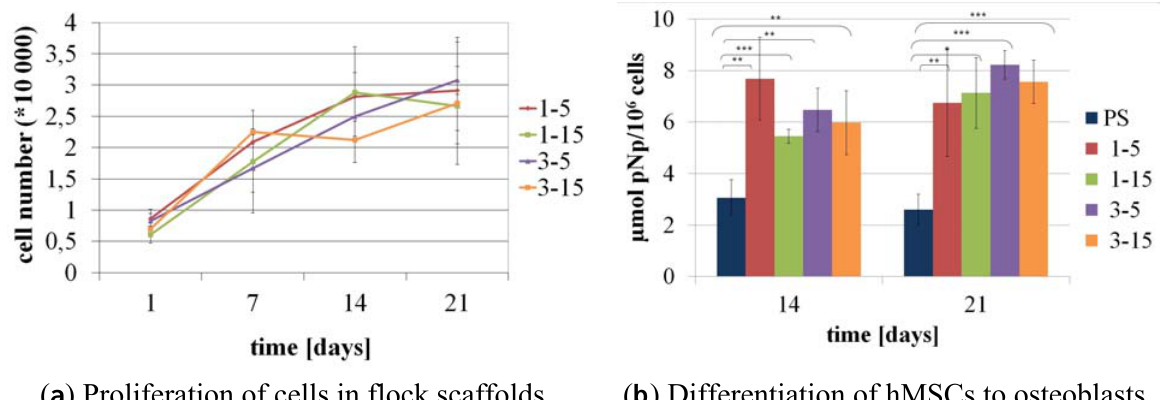
( a ) Proliferation of cells in flock scaffolds. ( b ) Differentiation of hMSCs to